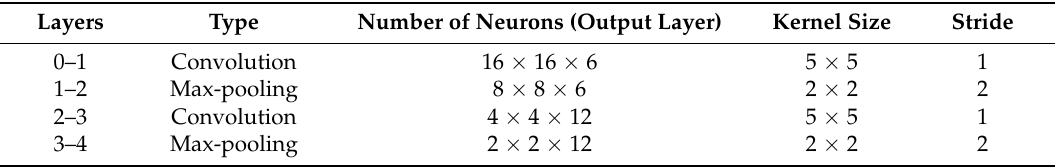
Table 4. Detailed parameter information of traditional Convolution Neural Network (CNN) used for ECG